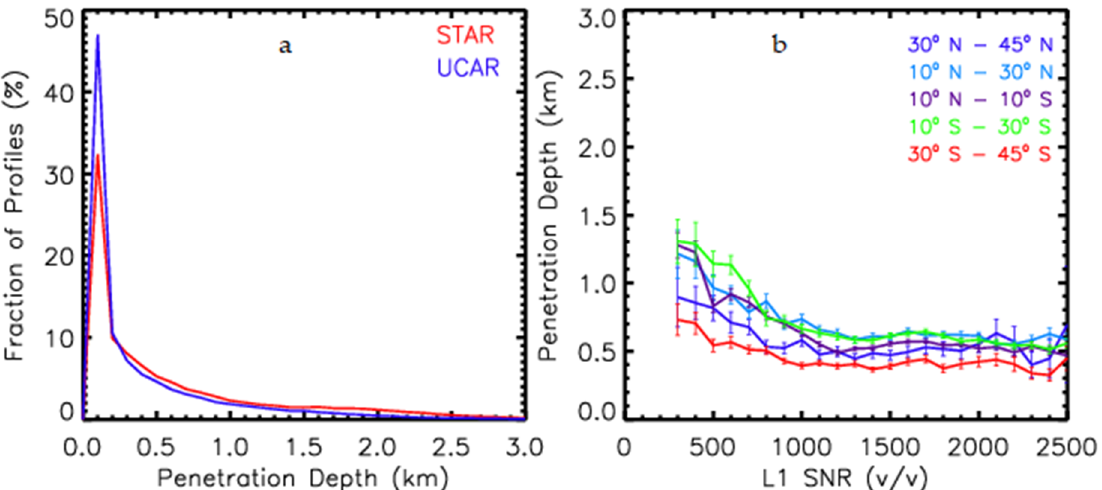
Figure 17. ( a ) The probability density function of the penetration depth at 0.1 km height bins, and ( b ) variations of the penetration depth as a function of SNR at 100 v/v intervals at different latitude ranges. Vertical bars represent the standard error of the